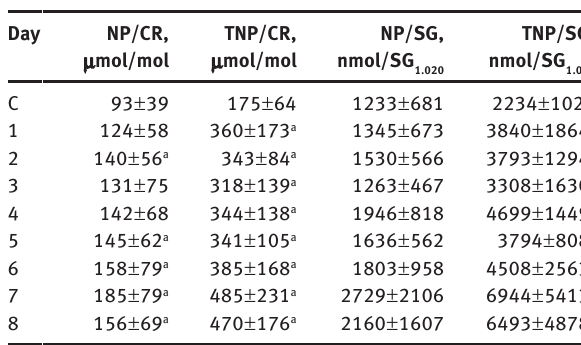
Table 2 Control subjects (C) and mean daily body building sub- jects’ neopterin and total neopterin concentrations corrected with creatinine and specific gravity.